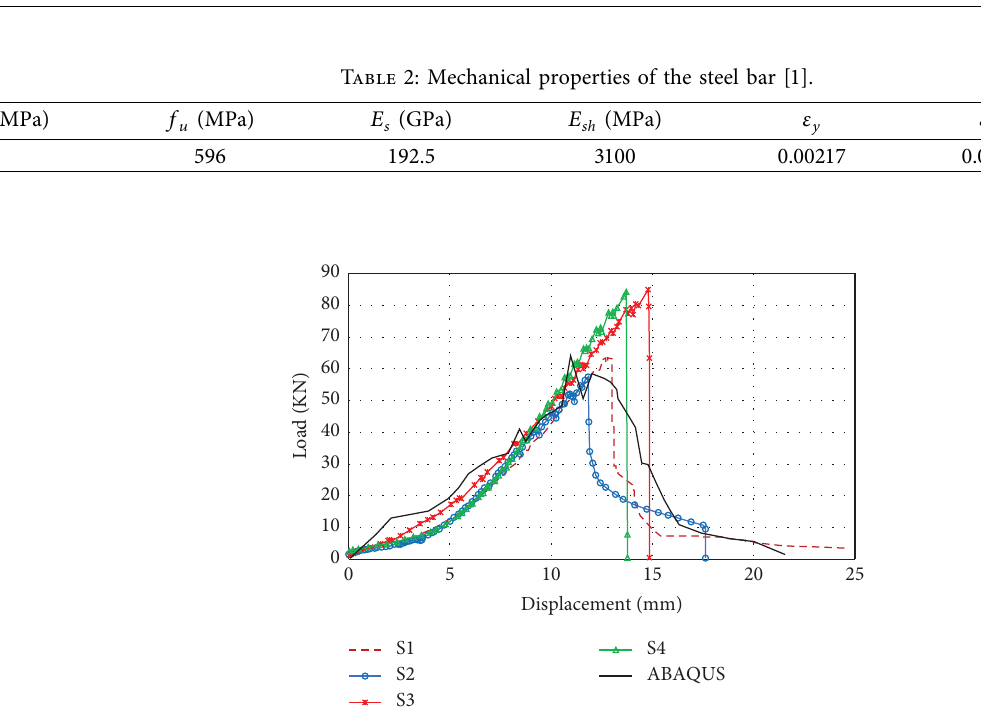
Figure 5: Te comparison of pull-out test curves and results of